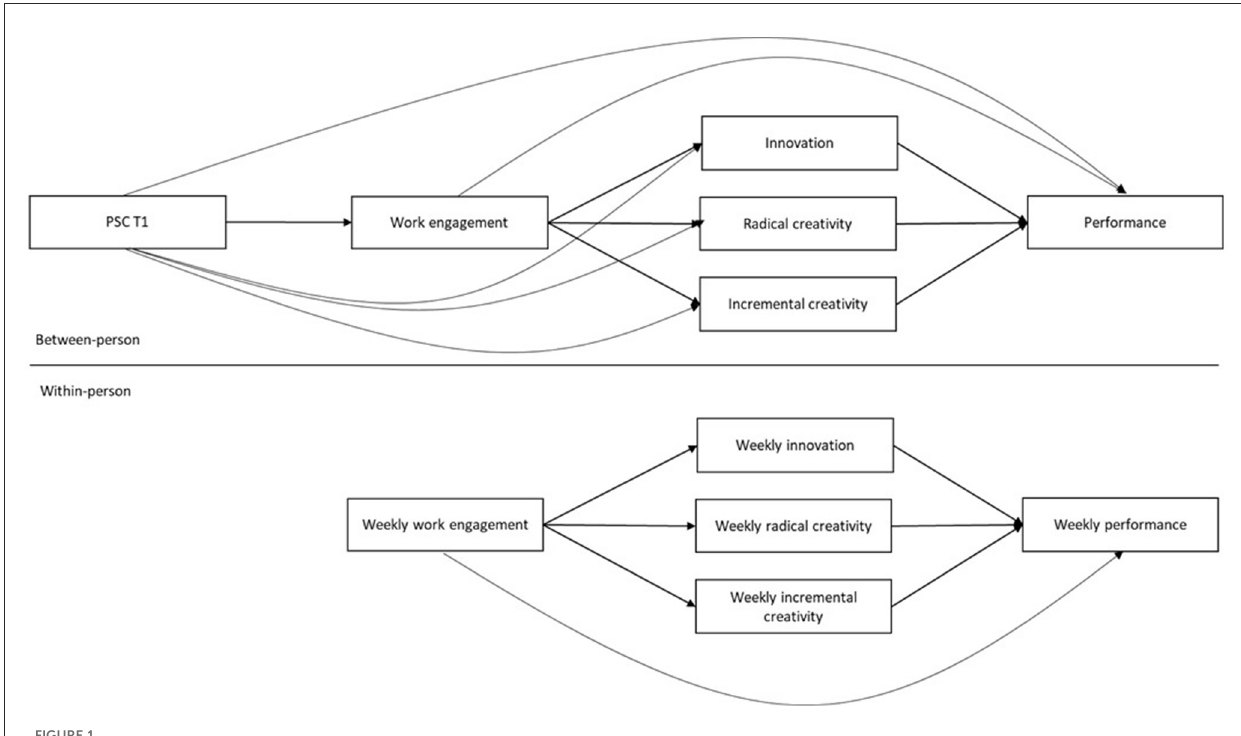
FIGURE1 Hypothesized